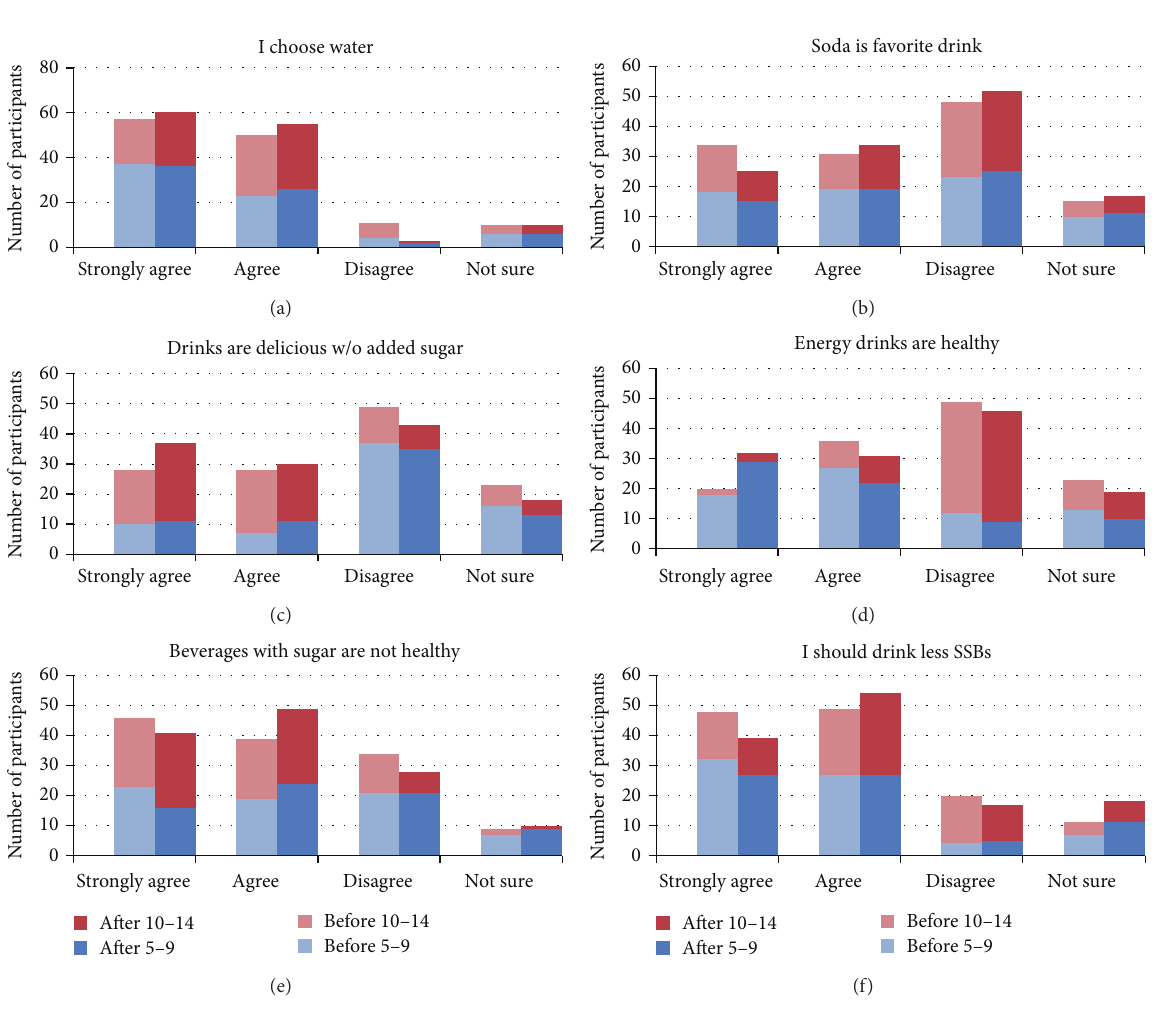
Figure 2: Baseline and postprogram responses to attitudinal